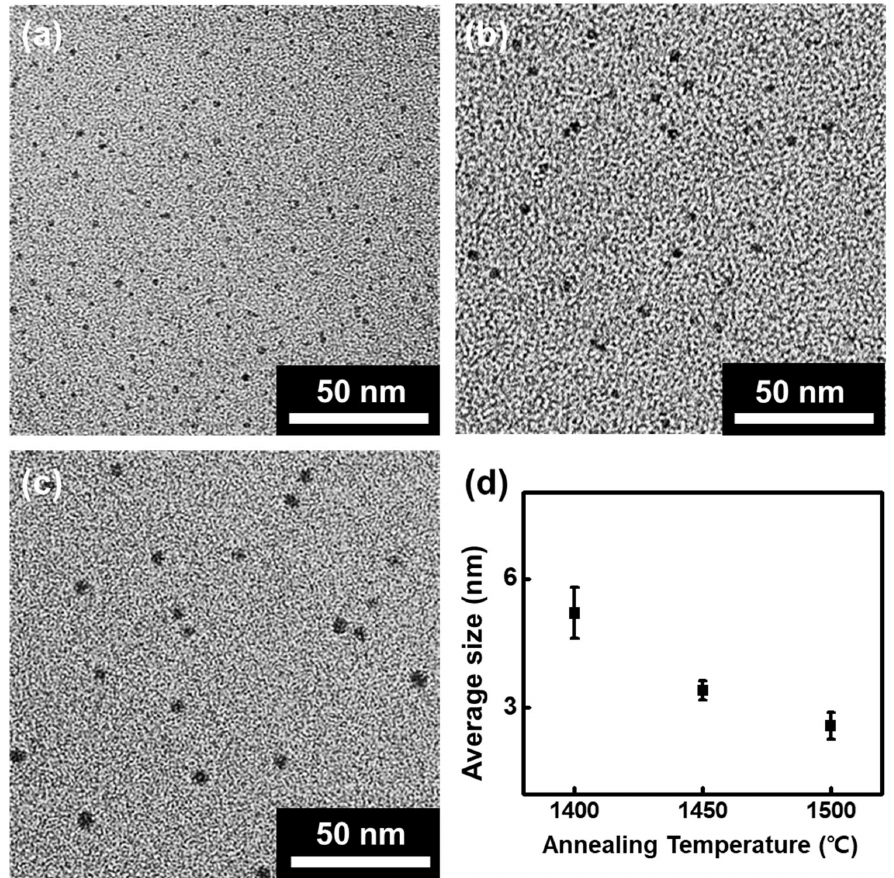
Figure 4. The HRTEM image of the GQDs fabricated on the SiC at a temperature of: (a) 1500 °C, (b) 1450 °C, (c) 1400 °C, (d) The correlation graph between the annealing temperature and the average size of the GQDs.